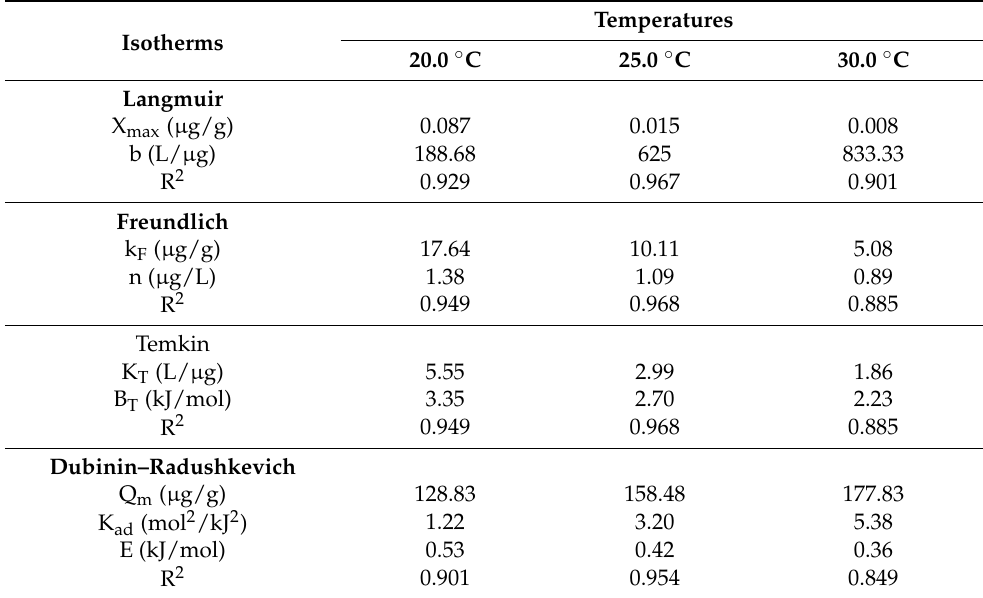
Table 1. The adsorption isotherm parameters of